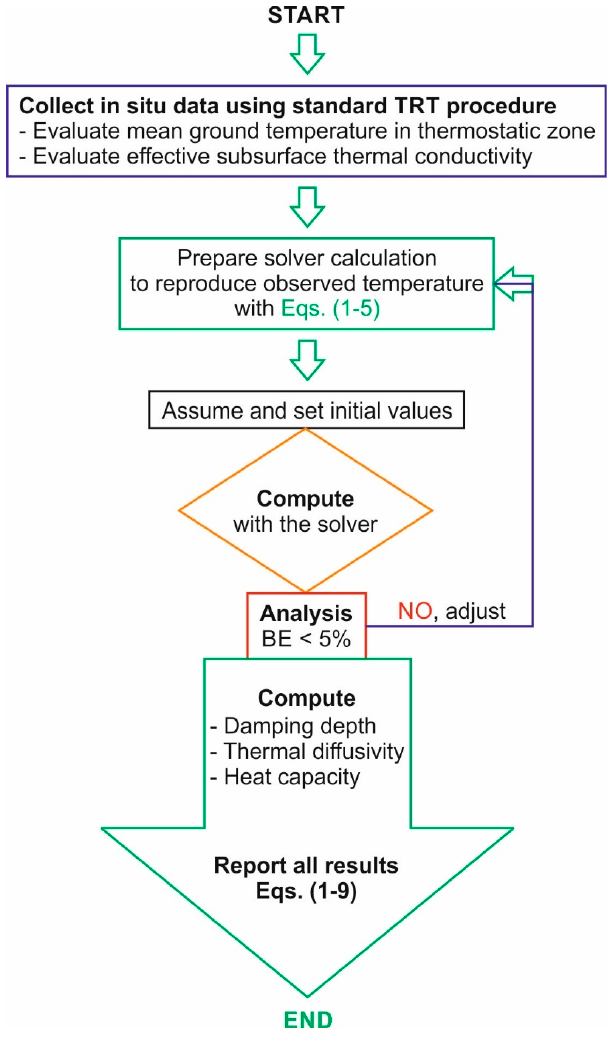
Figure 3. Procedure for assessing the in situ HC from a temperature profile undisturbed by a TRT and the in situ TC inferred from the TRT. and the in situ TC inferred from the